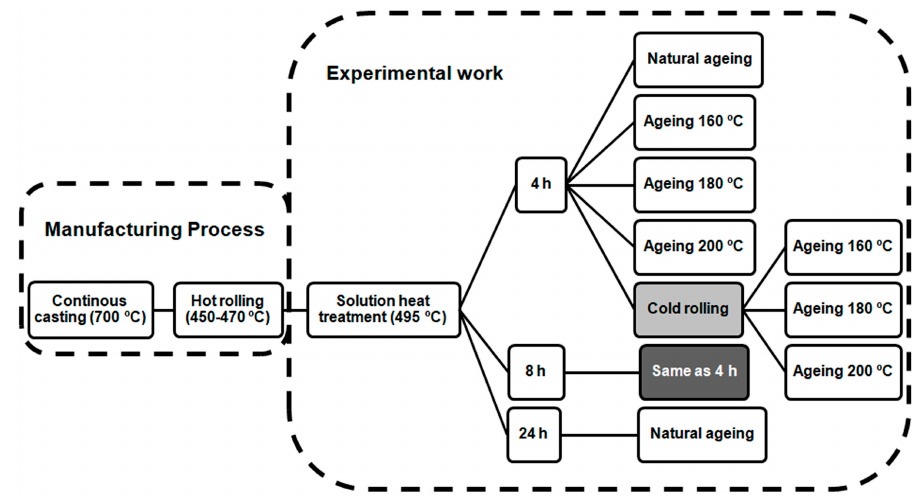
Figure 1. Description of the experimental process followed.